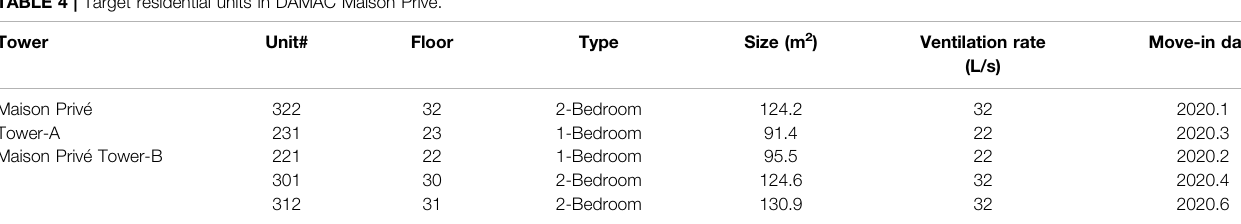
TABLE 4 | Target residential units in DAMAC Maison Privé.